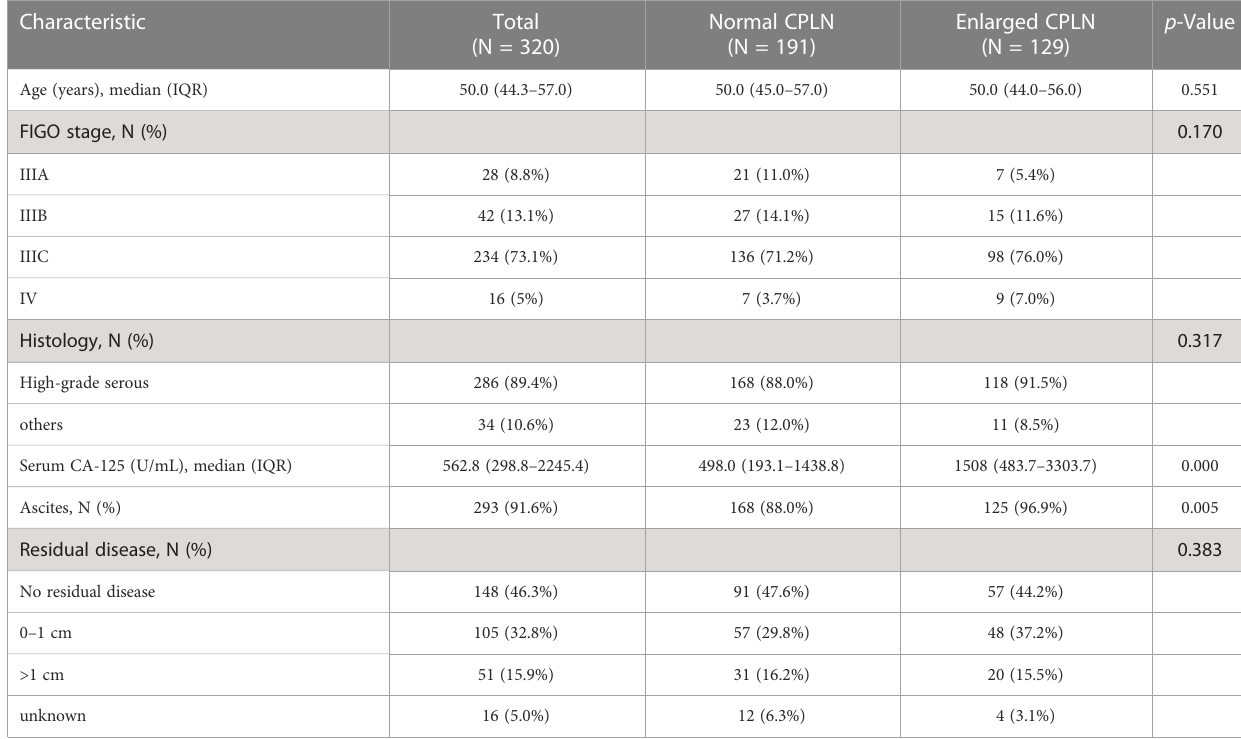
TABLE 1 Patient and tumor characteristics by presence of enlarged CPLN where enlarged CPLN de fi ned as ≥ 5 mm on the short